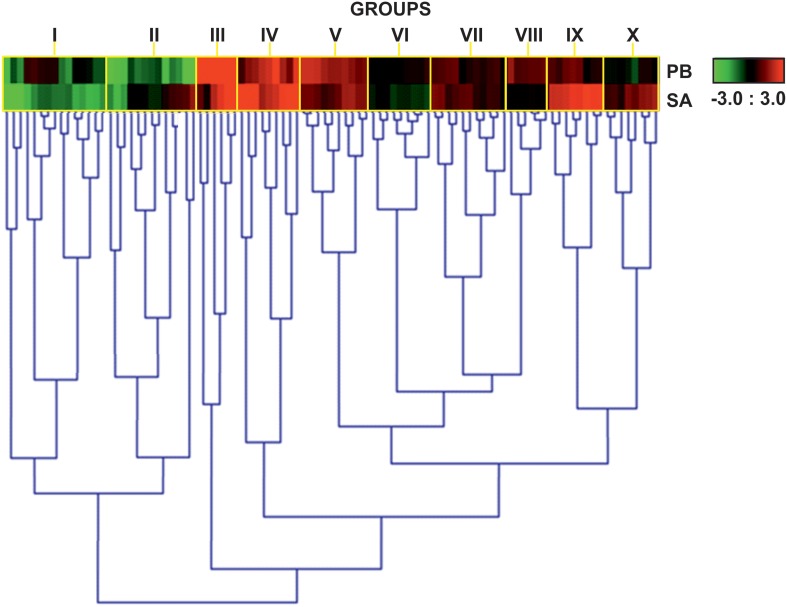
Heat map expression profiles of TF genes. Heat map showing expression profiles of 95 genes that were differentially expressed in Parabinga (PB) and SA1306 (SA) M. truncatula genotypes in response to E. Pisi infection. Genes were considered differentially expressed if they met the prerequisites p ≤ 0.05 and m ≤ −0.7 or m ≥ 0.7. Up-regulation (m ≥ 0.7) is indicated in red; down-regulation (m ≤ −0.7) in green; black indicates no differential expression (−0.7 ≤ m ≤ 0.7). The heat map expression profiles are grouped by yellow rectangles (I–X). Additional information is available in Table 1.